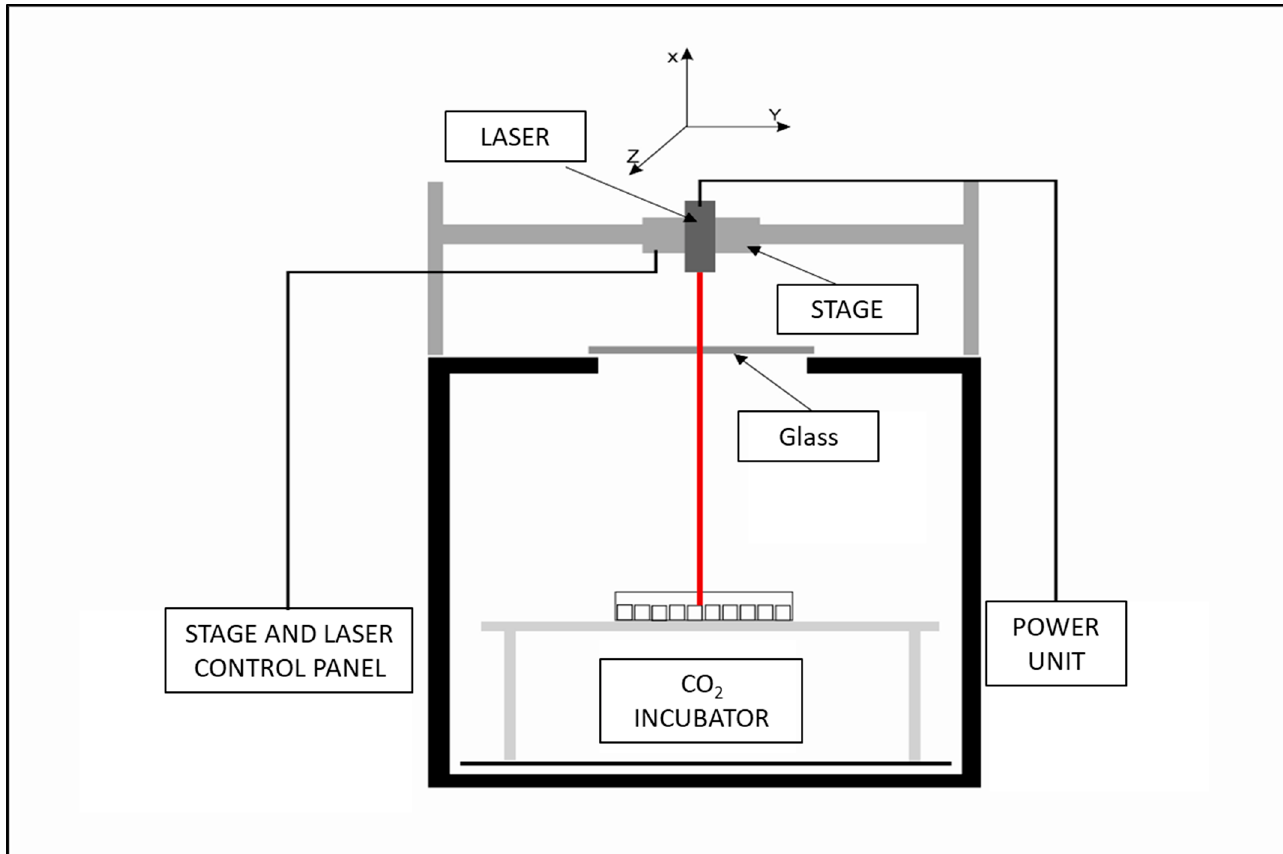
Figure 5. Laser exposure system schematics.